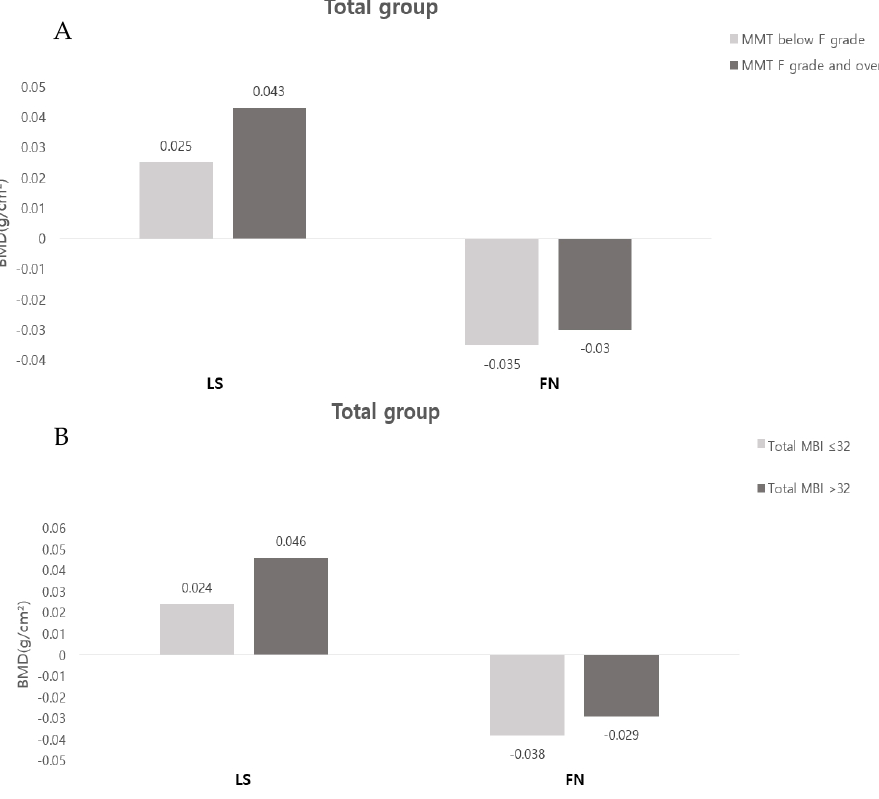
Figure 2. Changes in absolute BMD according to MMT and MBI: ( A ) comparison according to MMT; ( B ) comparison according to MBI. Abbreviations: LS, lumbar spine; FN, femoral neck; MMT, manual muscle test; MBI, modified barthel index.